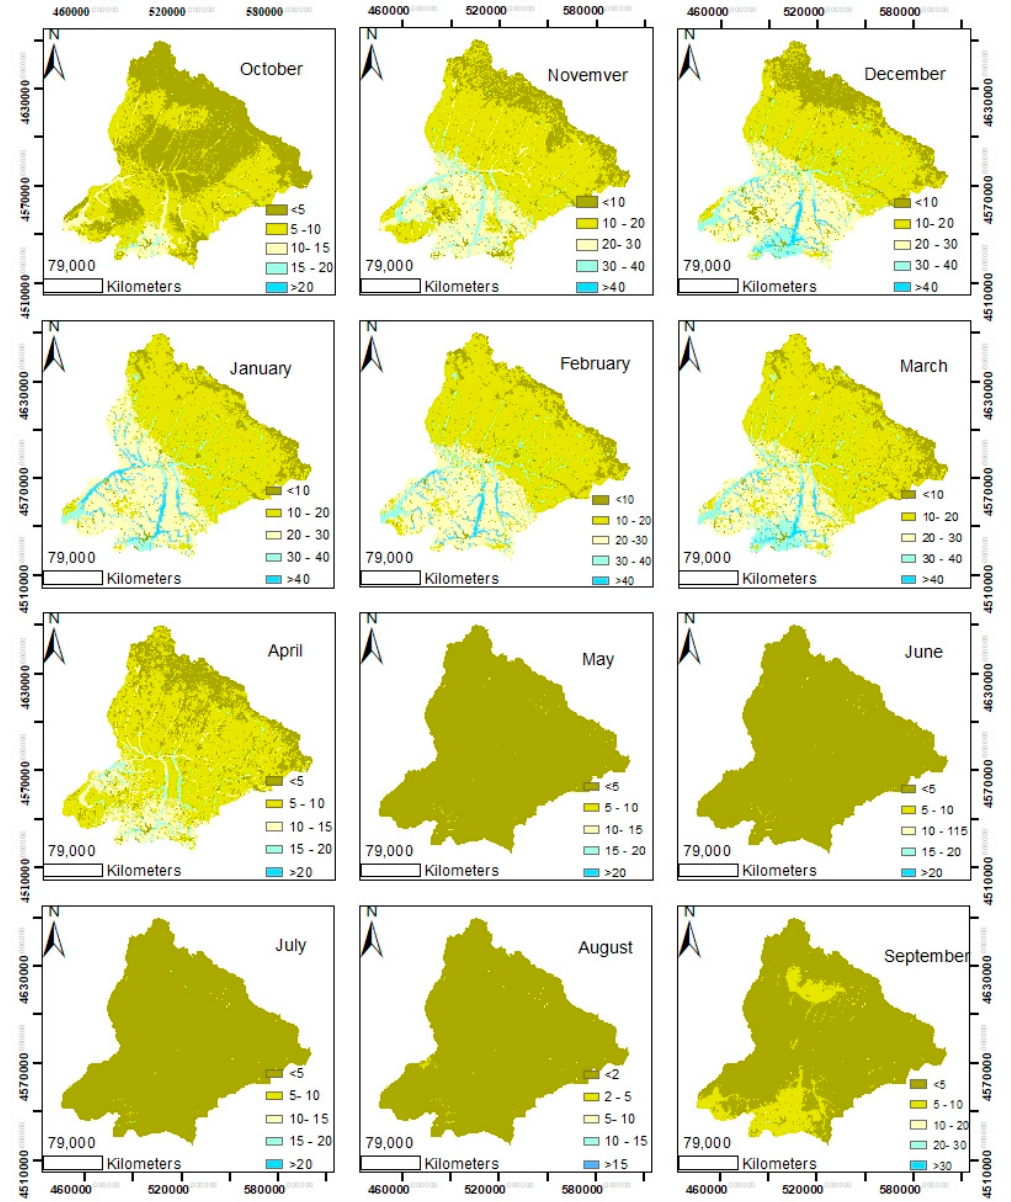
Figure 7. Long-term monthly groundwater recharge for the period